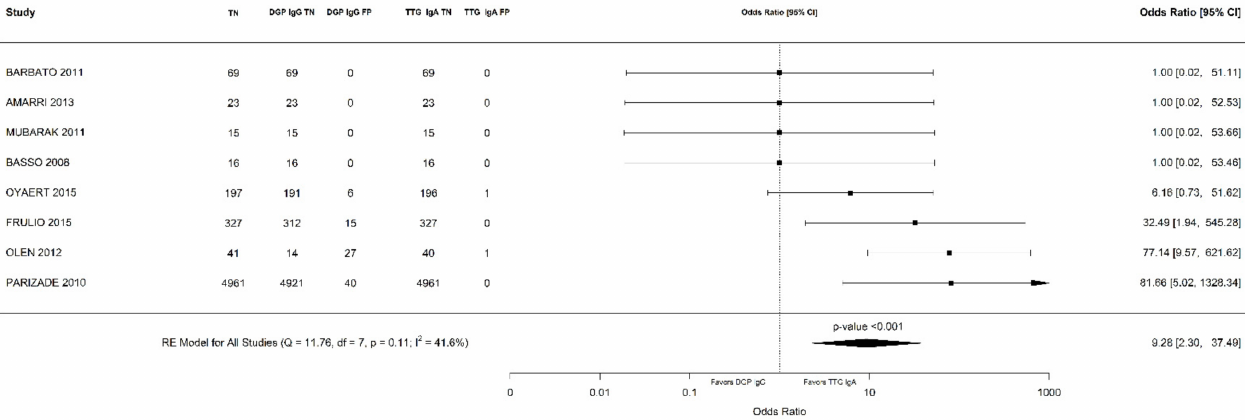
Figure 5. Forest plot of direct comparison of specificity between immunoglobulin G anti-deamidated gliadin peptide antibody (DGP IgG) and immunoglobulin A anti-tissue transglutaminase antibody (TTG IgA) determination. Only comparative primary studies reporting the number of total true negatives (TN) and false positives (FP) for DGP IgG and TTG IgA are included. Overall, out of 7553 children included in the systematic review, 319 had a